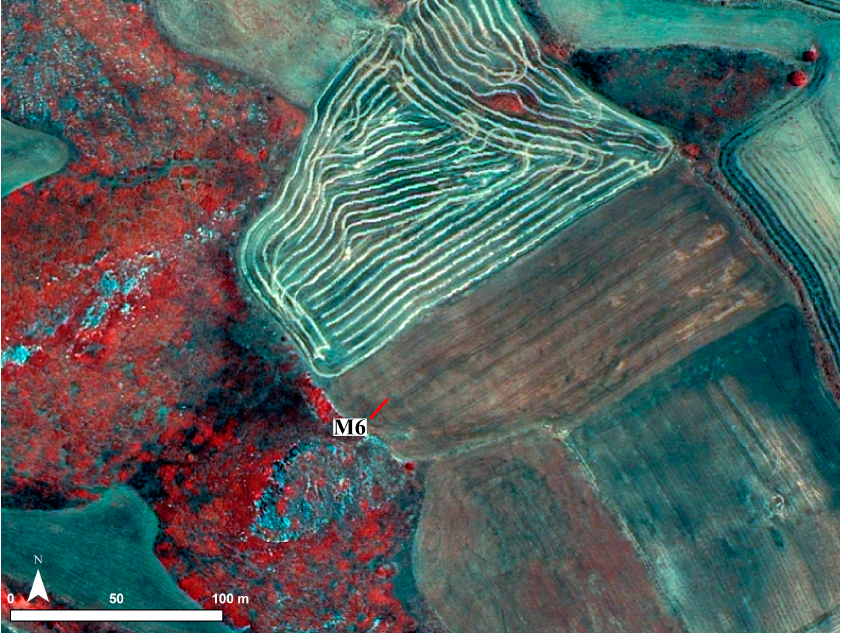
Figure 13. False color (Bands 4-2-1) GeoEye-1 imagery (acquisition date: 3 June 2010).